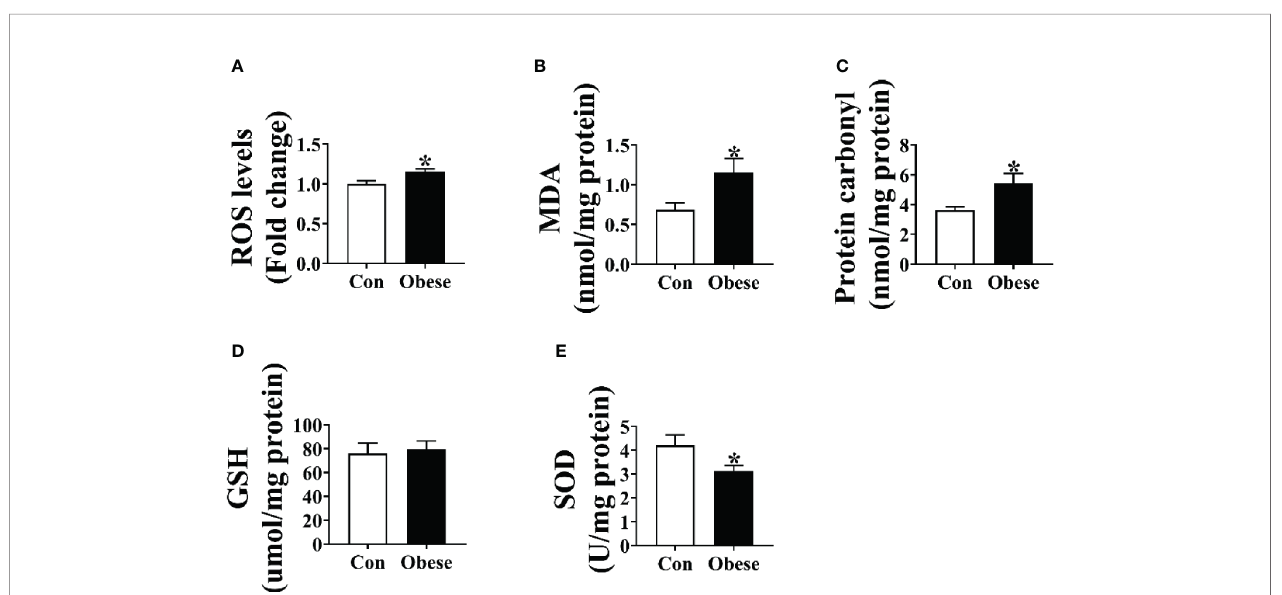
FIGURE 2 | Oxidative stress levels in placentae. Placental ROS (A) , MDA (B) , protein carbonyl (C) , GSH (D) , and SOD (E) levels. Values are mean ± SEM, n = 8. “ * ” indicates statistically signi fi cant differences ( P <